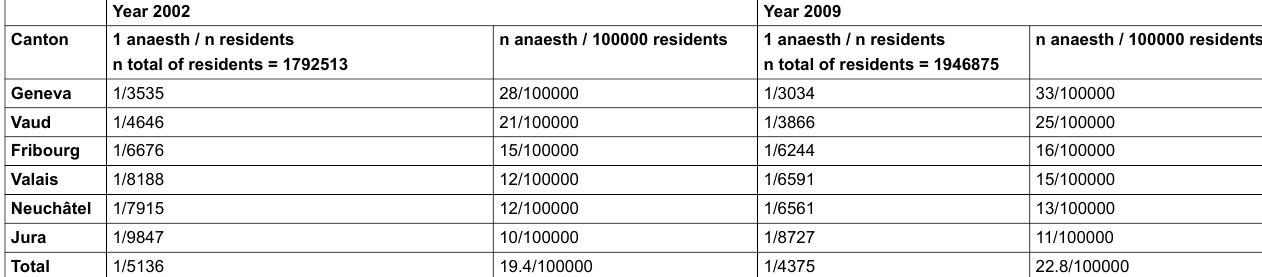
Table 2: Density of anaesthetists for each canton in 2002 and